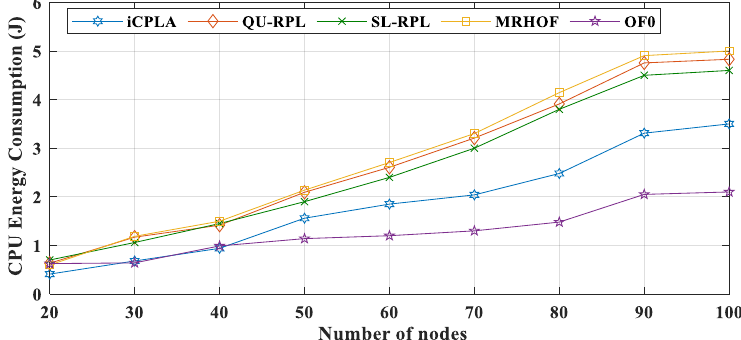
Figure 13. Comparison of CPU energy consumption (J) between i CPLA, QU-RPL, SL-RPL, MRHOF, and OF0 with 𝛼 = 0.3 and 𝛽 = 0.7 in a network of 20 to 100 nodes.